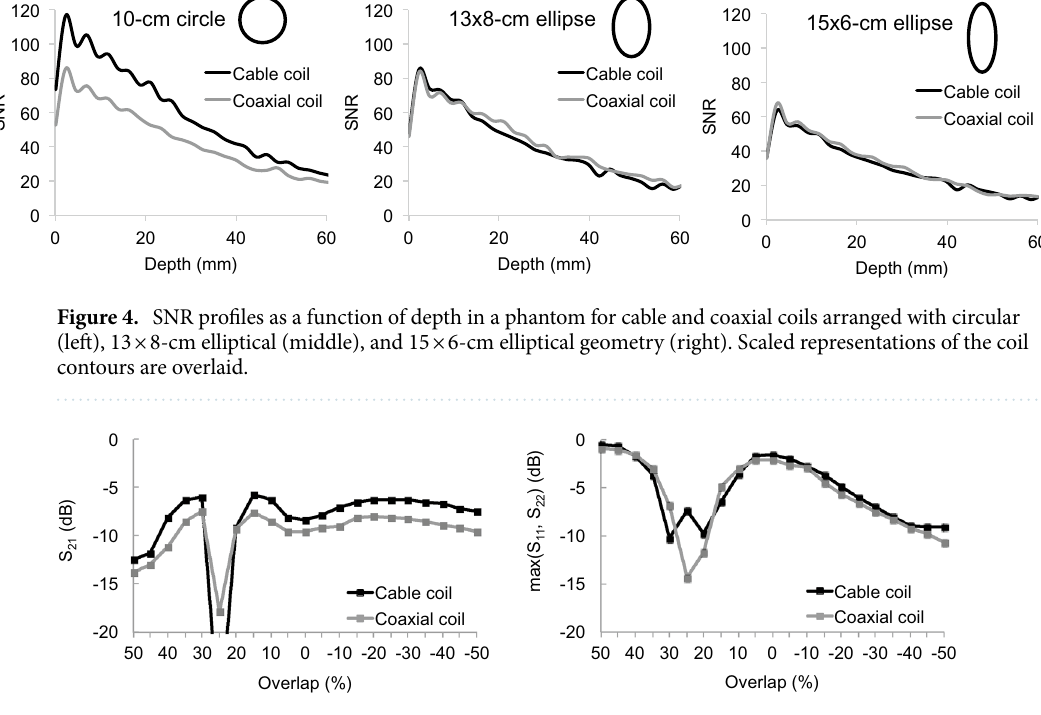
Figure 5. S-matrix measurements as a function of overlap for two-channel arrays based on cable and coaxial loops. Left: transmission coefficient (S 21 ). Right: maximum reflection coefficient (S 11 or S 22